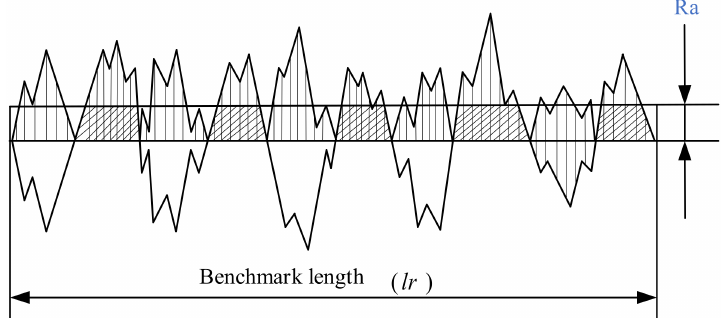
Figure 2. The arithmetic mean height of the contour